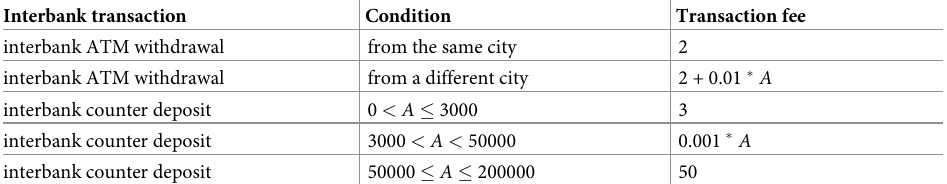
Table 5. Transaction fee